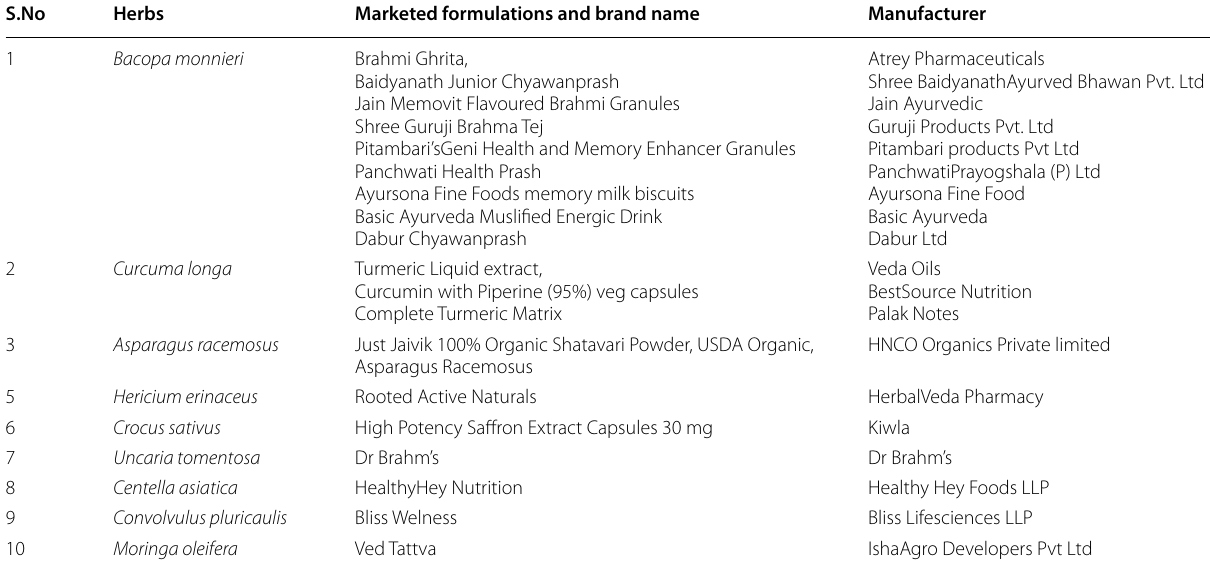
Table 2 Marketed formulations of the given herbs S.No Herbs Marketed formulations and brand